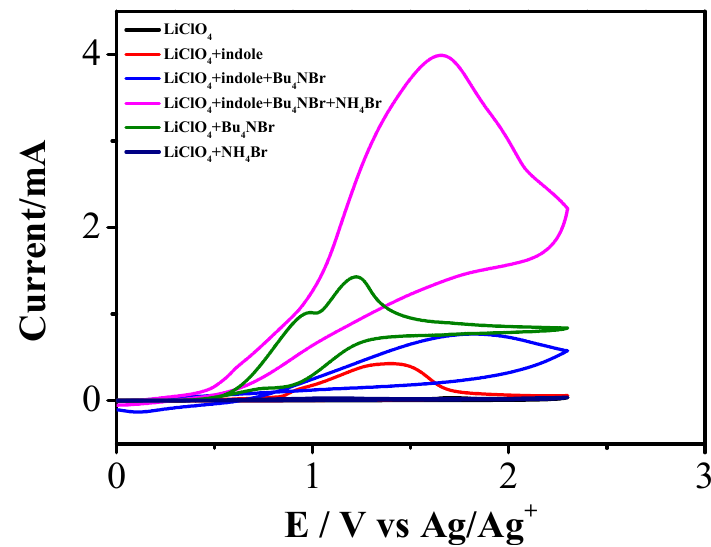
Figure 1. Cyclic voltammetry investigation of indole and bromide salts. Conditions: LiClO 4 (0.1 M in MeCN) as background supporting electrolyte, glassy carbon as working electrode, Pt wire as counter electrode, Ag in AgNO 3 (0.01 M)–LiClO 4 (0.1 M) in MeCN as reference electrode, indole (0.1 M), n Bu 4 NBr (0.1 M), and NH 4 Br (0.1 M). The scan rate is 100 mV/s.